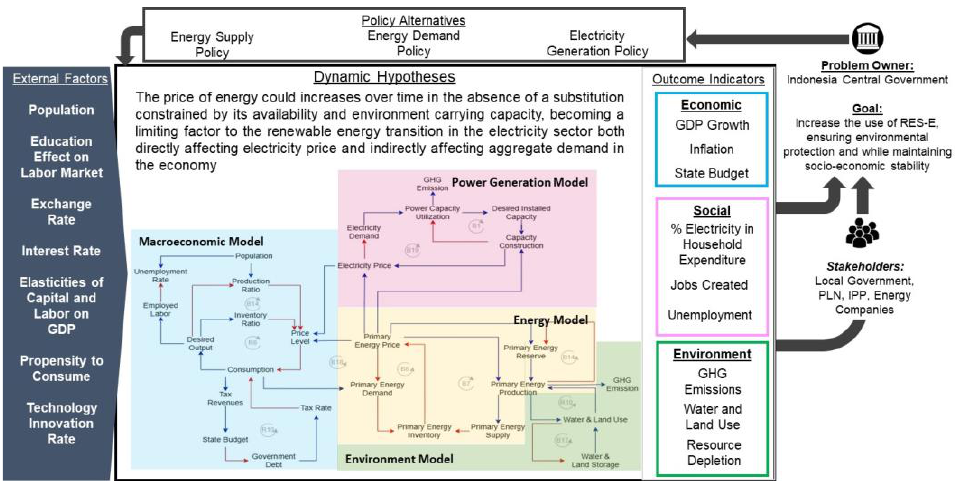
Figure 6. System Diagram of Energy Transition for Electricity Generation in Indonesia.